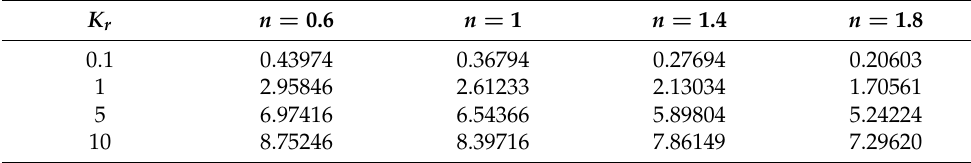
Table 14. The values of the average Nusselt number ( Nu avg ) at the heated